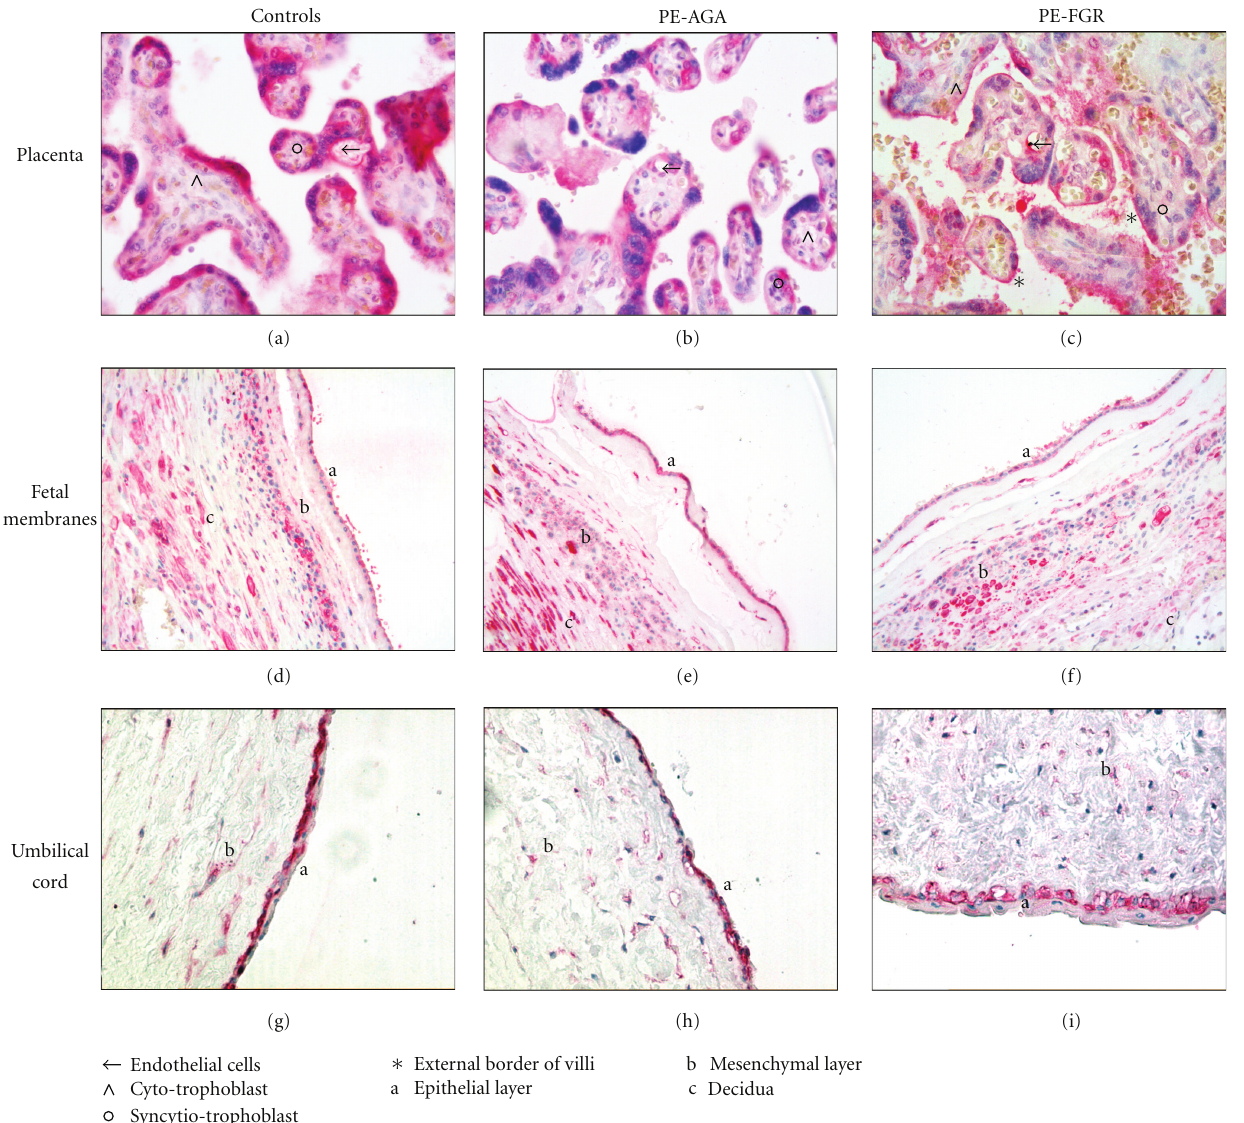
Figure 2: MIF immunoreactivity in tissues from normal and pathological pregnancies. Reddish color indicates positive staining for MIF. Representative images for placenta, fetal membranes, and umbilical cord from normal (a, d, g), PE-AGA (b, e, h) and PE-FGR (c, f, i) pregnancies, respectively. ( ← ): endothelial cells; ( ∧ ): cytotrophoblast; ( ◦ ): syncytiotrophoblast; ( ∗ ): external border of villi; a: epithelial layer; b: mesenchymal layer; c: decidua. Original magnification: 40x for placenta panel, 20x for fetal membranes and umbilical cord